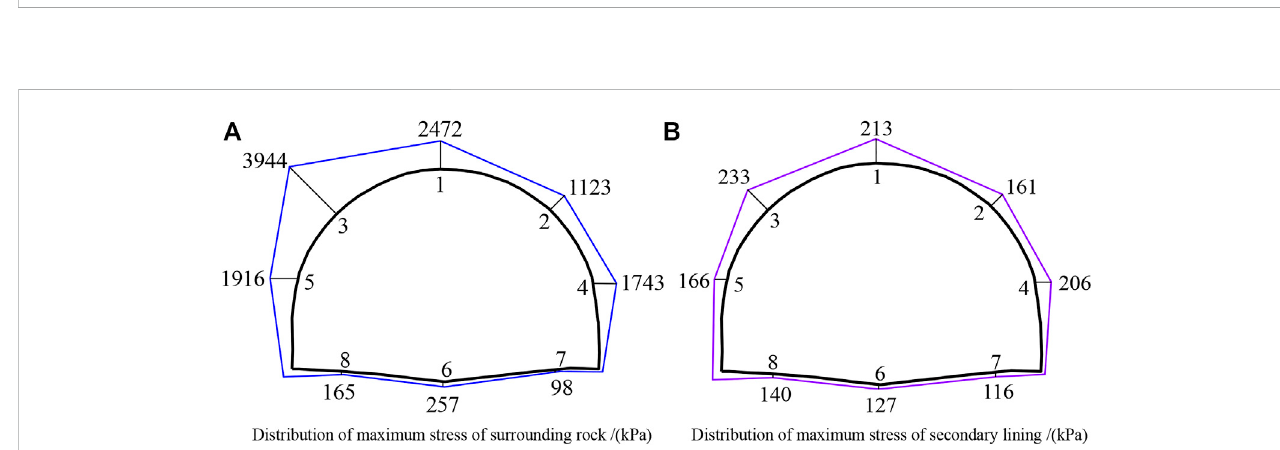
FIGURE 14 Distributionofmaximumstressofsurroundingrockandsecondarylining. (A) Distributionofmaximumstressofsurroundingrock/(kPa) (B) Distributionof maximum stress of secondary